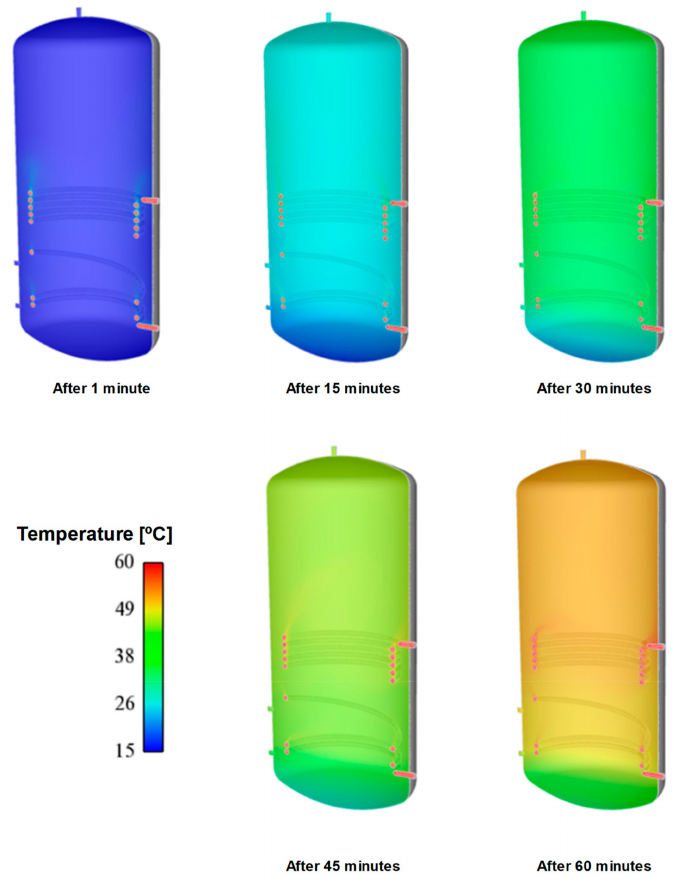
Figure 4. Temperature evolution in the middle plane of the tank